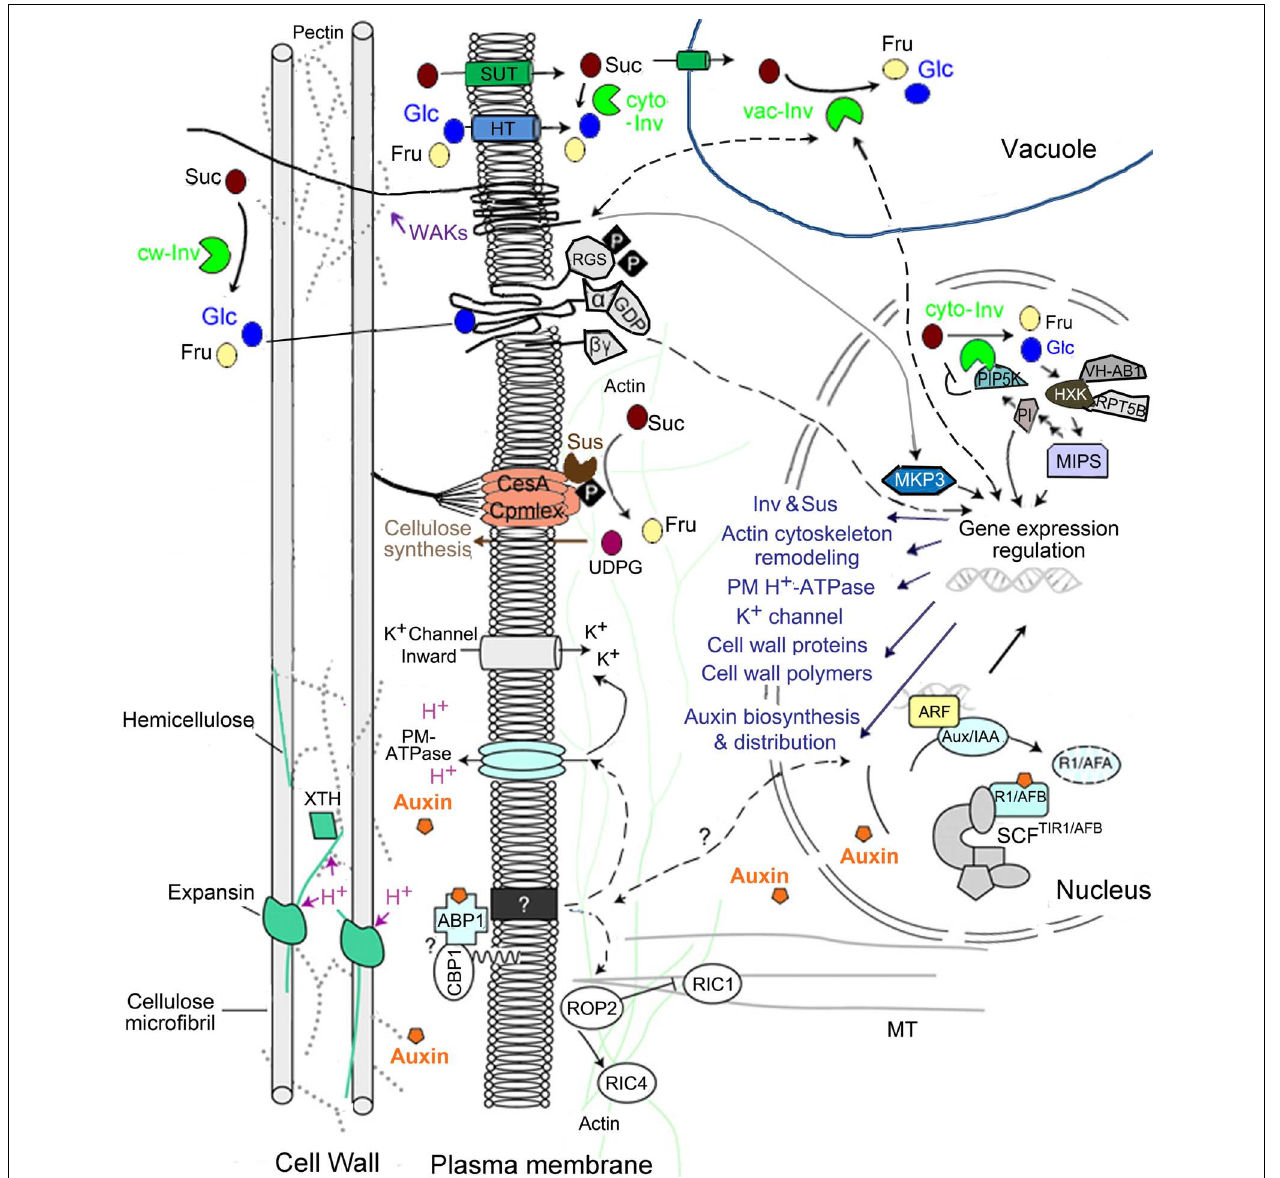
FIGURE 2 | Sugar and auxin signal in regulating sink cell expansion (modified from Perrot-Rechenmann, 2010, Figure 3). Unloaded Suc in sink tissues may enter into recipient cells either apoplasmically through cell wall matrix or symplasmically via plasmodesmatal. In the former case, sucrose could be taken up by sucrose transporter on plasma membrane, or be hydrolyzed by cw-Inv into Glc and Fru, and then be transported into cells by hexose transporter (HT). Apoplasmic Glc could be recognized by RGS1, which transmits extracellular sugar signal into the cell through G-proteins. In cytoplasm, Suc may be hydrolyzed by cyto-Inv or degraded by Sus. In the present of high Suc level, Sus intends to bind actin filaments and form a multi-protein complex bound to plasma membrane, which may facilitate cell expansion by providing UDPG for cellulose/callose biosynthesis. Cytoplasmic Suc could also be transported into nucleus, vacuole, plastid or mitochondrion. In vacuole, Suc could be hydrolyzed by vac-Inv, thus doubling the osmotic contribution of Suc, which has the potential to positively impact on cell turgor. Moreover, vac-Inv could also promote cell expansion via sugar signaling involvingWAKs, which subsequently activates MPK3 in nucleus, and induces downstream gene expression for cell wall biosynthesis. Suc hydrolysis